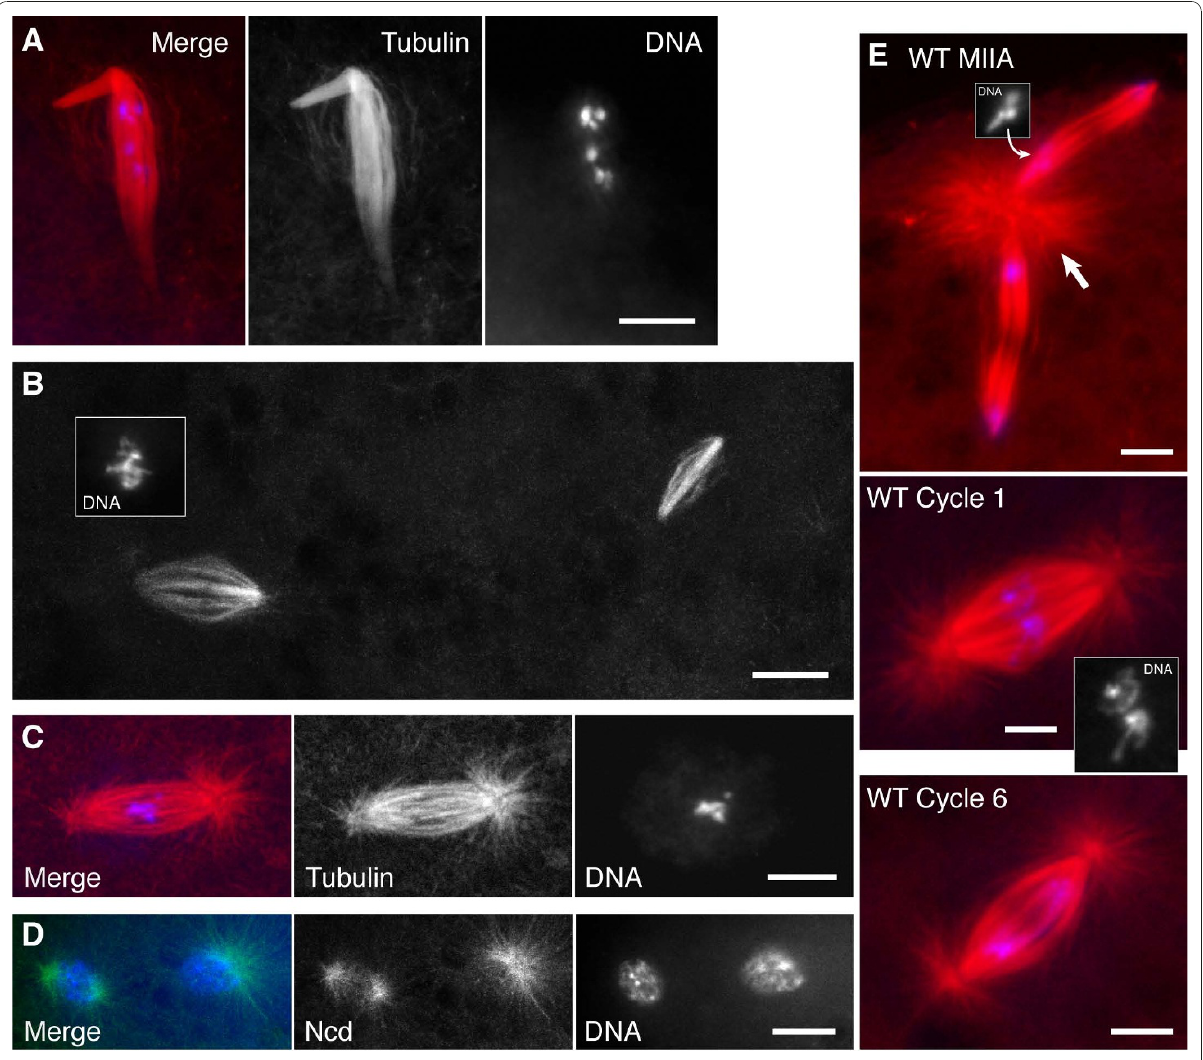
Figure 4 g Tub37C APL10 mutant embryos . (A) Anaphase I arrest. (B) Anastral spindles associated with MII metaphase chromosomes (inset) from an embryo containing 6 or more anastral spindles and a polar body with 1N chromosomes. (C) Astral cycle 1 mitotic spindle containing a haploid set of chromosomes. (D) Two small astral spindles associated with interphase or prometaphase nuclei from an embryo containing ~20 astral spindles (~cycle 6) and two pairs of MII-like anastral spindles without central spindle bodies. (E) Wild-type spindles. Top, anaphase II spindle with central spindle pole body (large arrow) and segregating haploid chromosome sets (inset); middle, cycle 1 mitotic spindle containing two haploid chromosome sets (inset); bottom, cycle 6 mitotic spindle. Tubulin, red; Ncd-GFP, green; DNA, blue. Bars, 5 μ